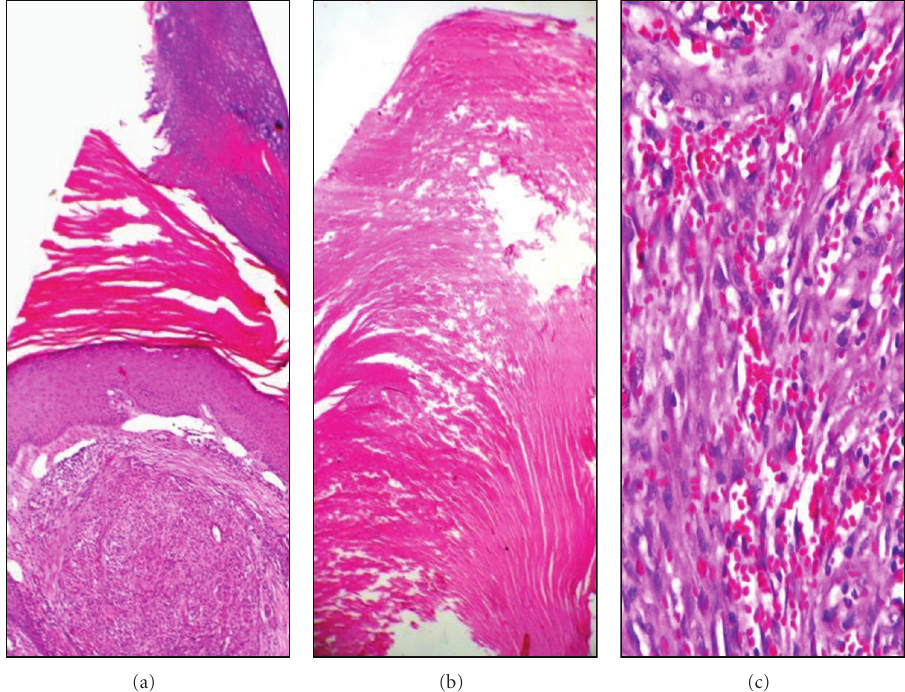
Figure 1: (a) Nodular stage Kaposi’s sarcoma containing compact keratin layer in the epidermis (Hematoxylin-Eosin [H-E], x40). (b) Lamellar keratin accumulation on the epidermis at the surface of the lesion (H-E, x100). (c) Neoplastic proliferation consisting of fusiform cells and extravasated erythrocytes in nodular stage Kaposi’s sarcoma (H-E, x200).